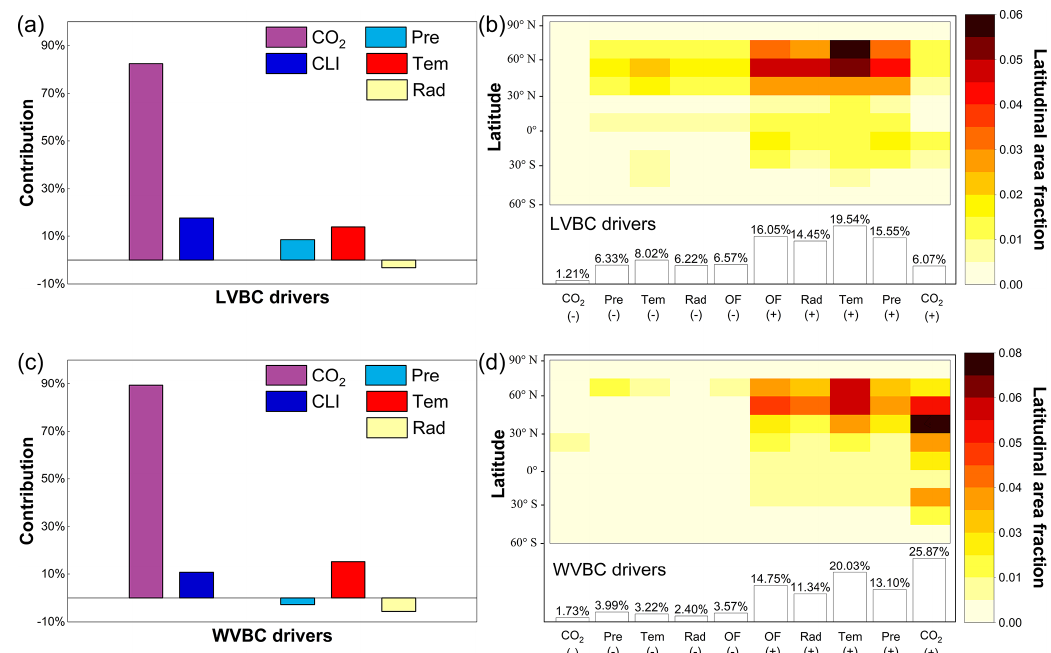
Figure 8. The proportion of changes in vegetation biomass carbon stocks attributed to driving factors. Ratios of the driving factors of CO 2 fertilization effects (CO 2 ), climate change effects (CLI), precipitation (Pre), temperature (Tem), and radiation (Rad) for LVBC (a) and WVBC (c) are calculated by the Mann–Kendall and Sen slope estimator statistical tests. Attribution of LVBC (b) and WVBC (d) dynamics to driving factors calculated as averages along 15 ◦ latitude bands. At the local scale, the driving factors include CO 2 , Pre, Tem, Rad, and other climate factors (OF). The fraction of global grid cells (%) that are predominantly influenced by the driving factors is shown at the bottom of the bar. The “–” symbol before the fraction indicates a negative effect of the driving factor on carbon stock, and vice